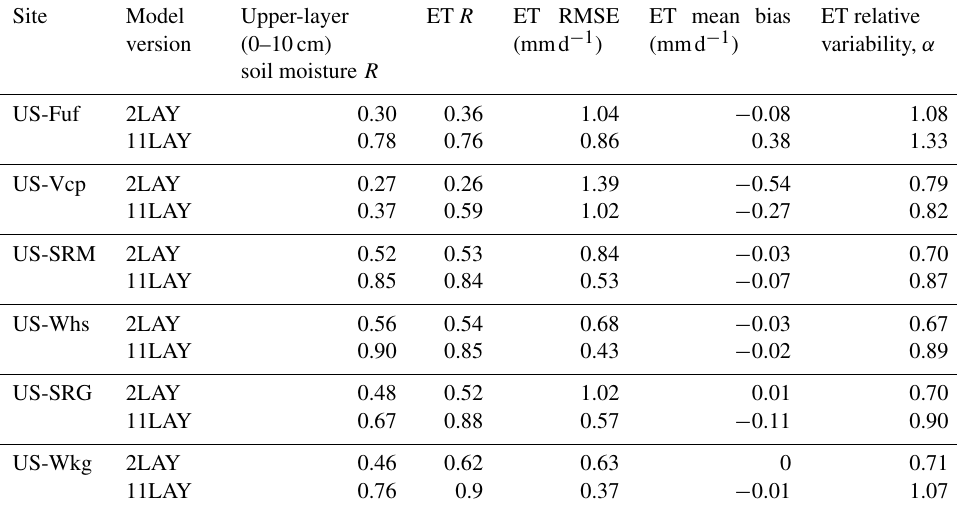
Table 4. Model evaluation metrics comparing the 2LAY and 11LAY daily upper-layer soil moisture (re-scaled via linear CDF matching) and daily ET simulations to observations across the whole time series (where data are present – see Fig. S2). Metrics include correlation coefficient ( R ), root mean squared error (RMSE), mean absolute bias, and a measure of the relative variability, α , between the model and the observations. The mean absolute bias = model − observations; therefore, a negative value represents a mean model underestimation of observed ET. α = σ m (see Sect. 2.4, with “ideal” values approaching σ o